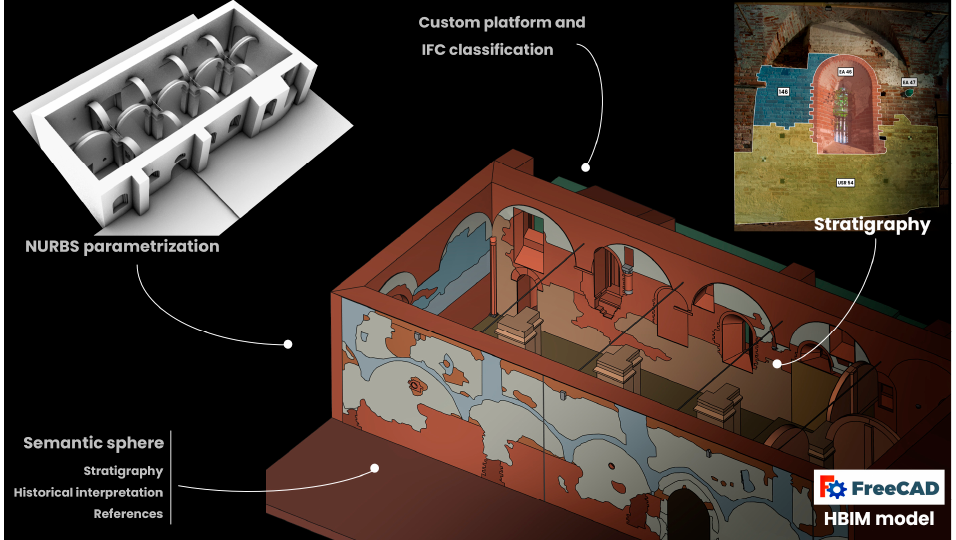
Figure 2. The Staffarda refectory project: HBIM model designed from reality-based data and NURBS reconstruction. Stratigraphy and other historical information implemented for future